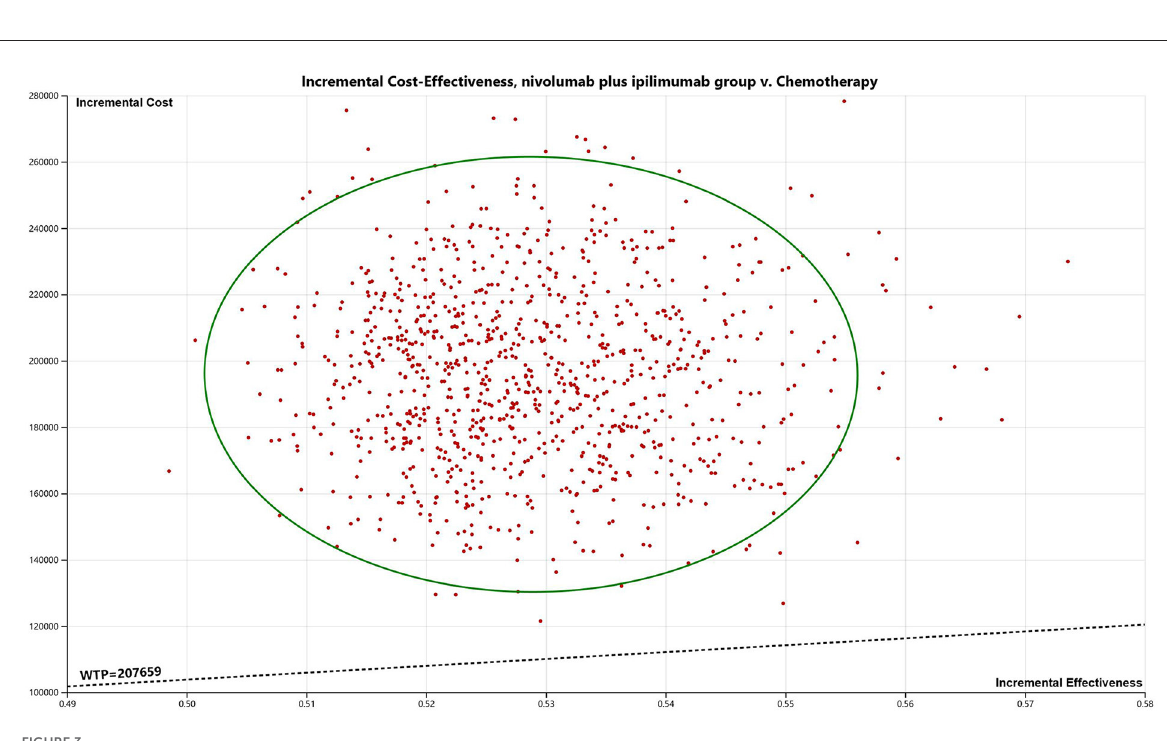
FIGURE3 Incremental cost-effectiveness scatter plot (nivolumab plus ipilimumab vs.